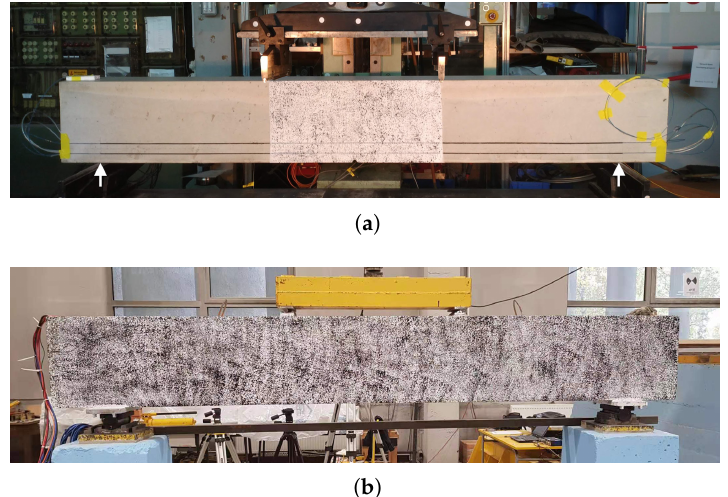
Figure 5. Front view of the beams and contract points position ( a ) At BAM and ( b ) at NEOSTRAIN. Multiple sensoring techniques are applied in the two bending test. The details of the techniques are listed in Table